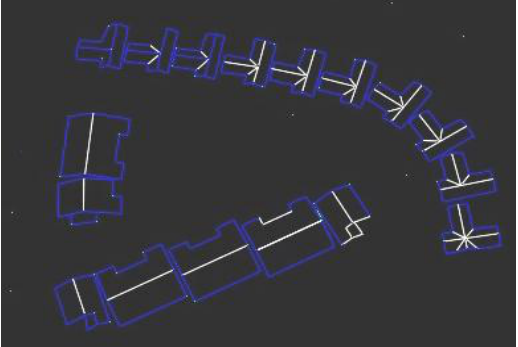
Figure 7. Left one: Building roof extraction from UAV images;